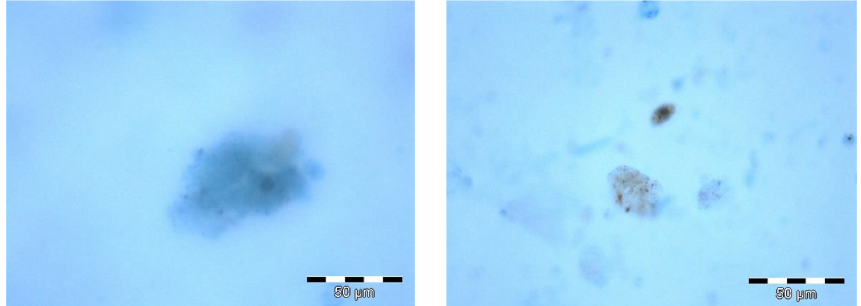
Figure 1. Microscopic analysis of transparent exopolymer particles (TEPs) from the cloud water sample “WW5” (sampling interval: 28 September 19:30LT–29 September 07:30LT). Blue particles are TEPs, stained with Alcian Blue solution; brownish particles in the right picture are assumed to be dust particles. The scale refers to